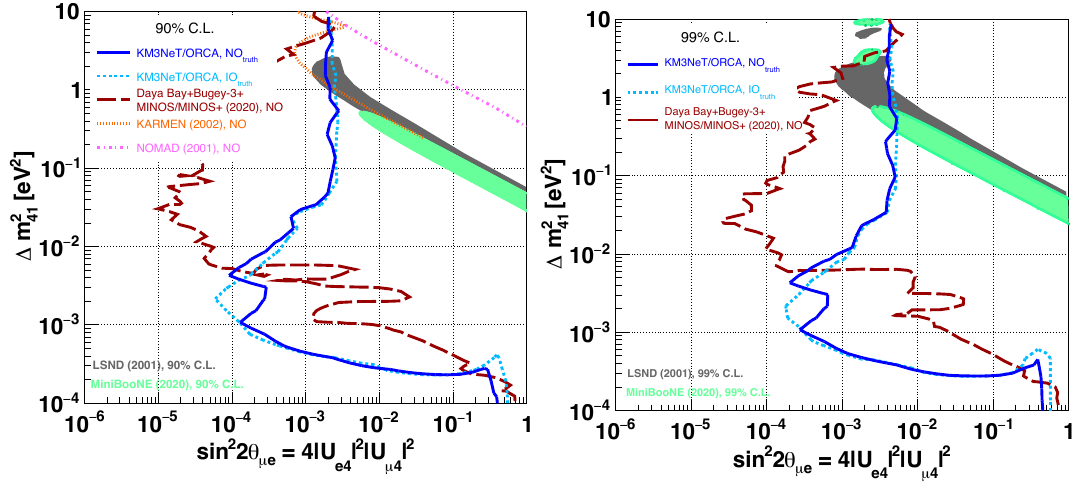
Figure 10 . The 90% (left) and 99% C.L. (right) KM3NeT/ORCA sensitivity to the mixing pa- rameter | U µe | 2 , assuming three years of data taking. Sensitivity results are compared with current upper limits from Daya Bay+Bugey-3+MINOS/MINOS+[44], KARMEN [49] and NOMAD [50]. Current anomaly regions from LSND [11] and MiniBooNE [12] are also reported. The excluded region is the one on the right of the lines.